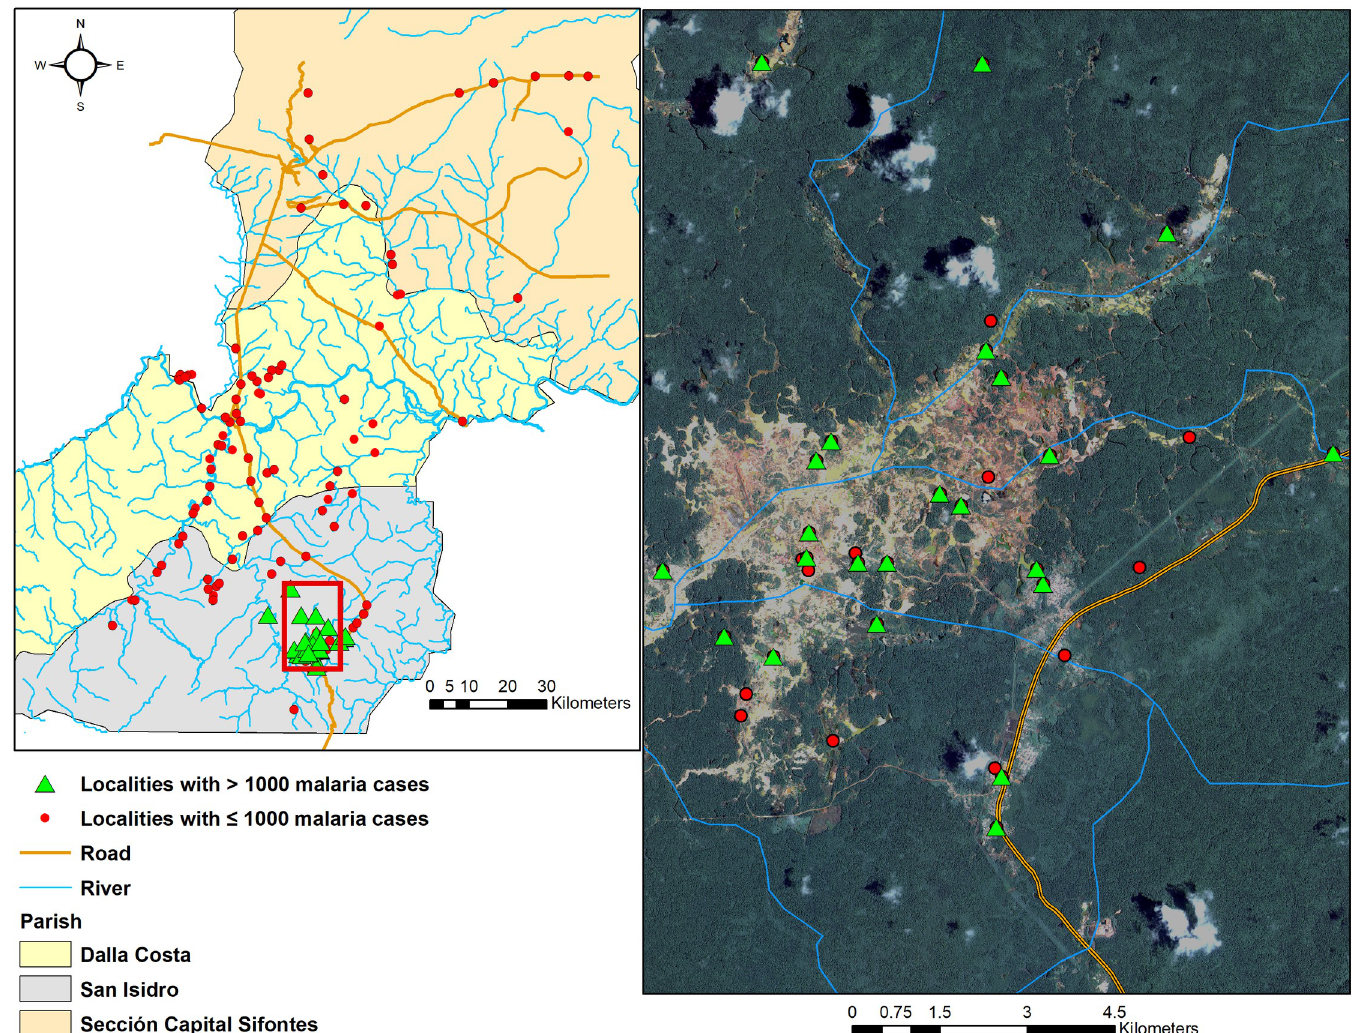
Fig 5. Left: Sifontes Municipality and its three parishes showing the spatial distribution of all localities and some general landscape features. Right: satellite image (source: Landsat 8, spatial resolution: 15m, date: 12/19/2017) of “Las Claritas” (framed in red window in San Isidro Parish); green triangles: localities with > 1,000 malaria cases across the study period in the deforested mining area; red dots are localities with < 1,000 malaria cases. Maps were created with the Q-GIS software (https://